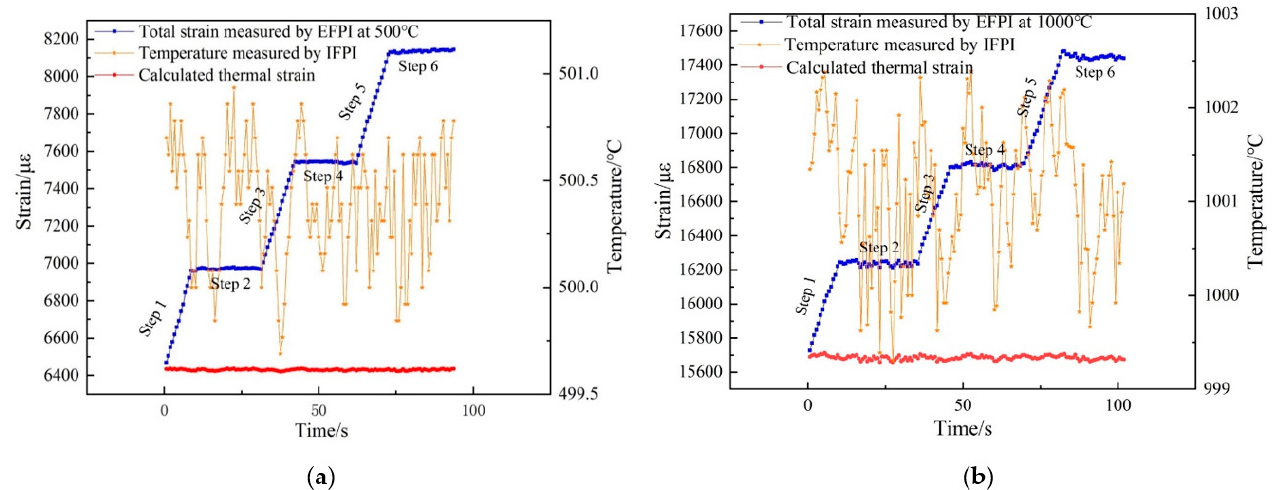
Figure 11. Real-time response of temperature and strain measured by CFPI sensor under different high temperatures with variable load, thermal strain calculated by Equation (8) as well, ( a ) under 500 °C; ( b ) under 1000 °C.